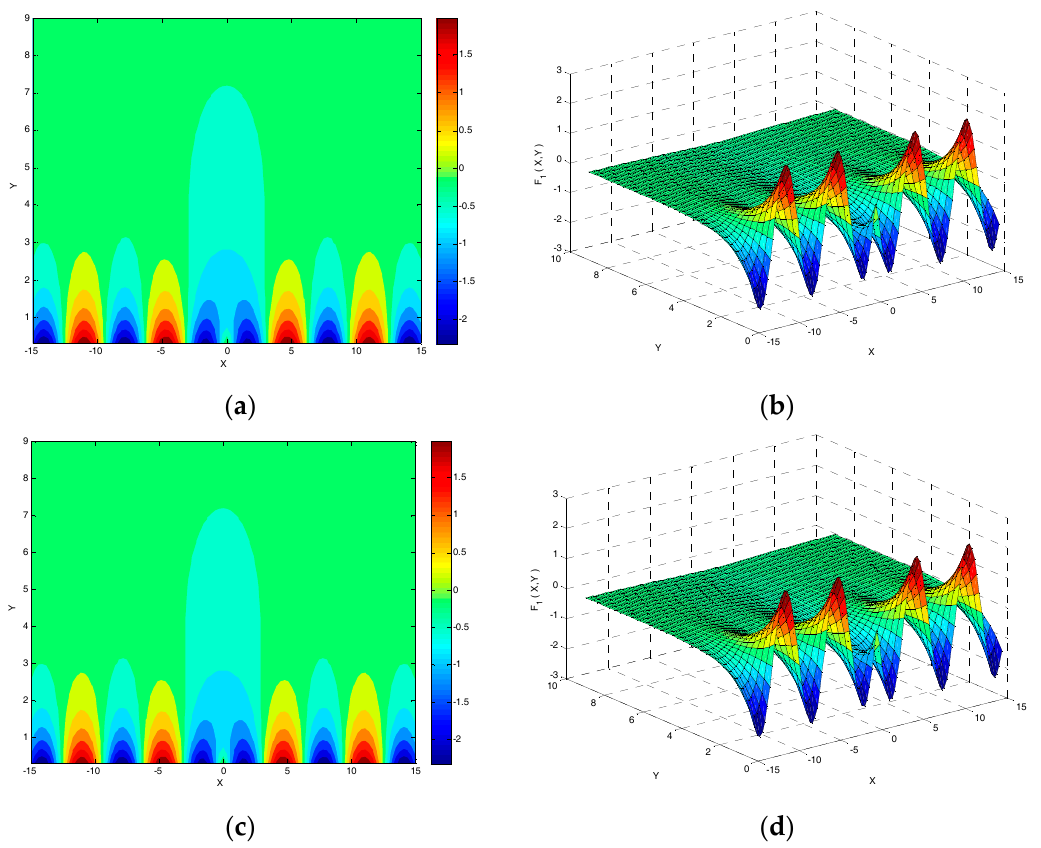
Figure 2. Comparison of the singular function F 1 ( X , Y ) calculated by the two methods: ( a ) contour plot by direct integration; ( b ) oblique view by direct integration; ( c ) contour plot by analytical solution; and ( d ) oblique view by analytical solution.